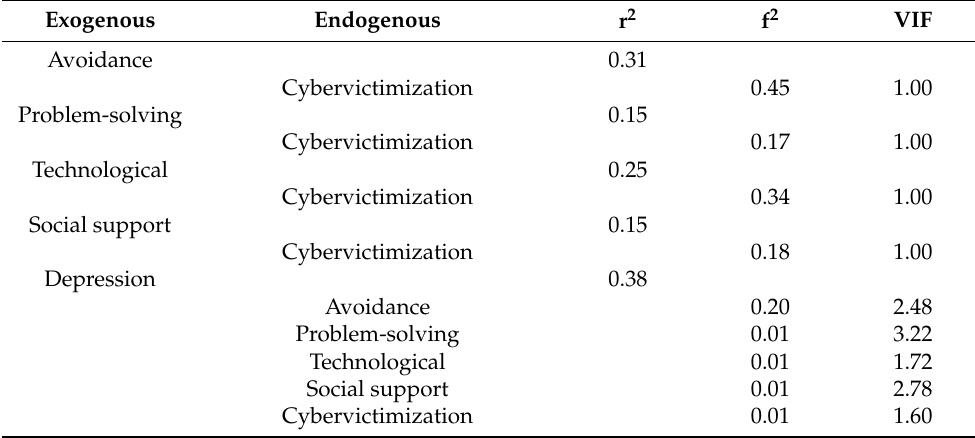
Table 2. Coefficient of determination (r 2 ), effect size (f 2 ), and collinearity statistics (VIF) of Measurements.